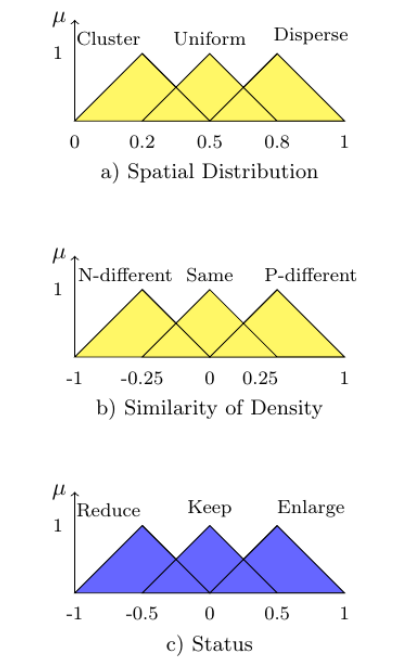
Figure 7. CW adjustment fuzzy membership functions. Table 2. CW size adjustment rules.